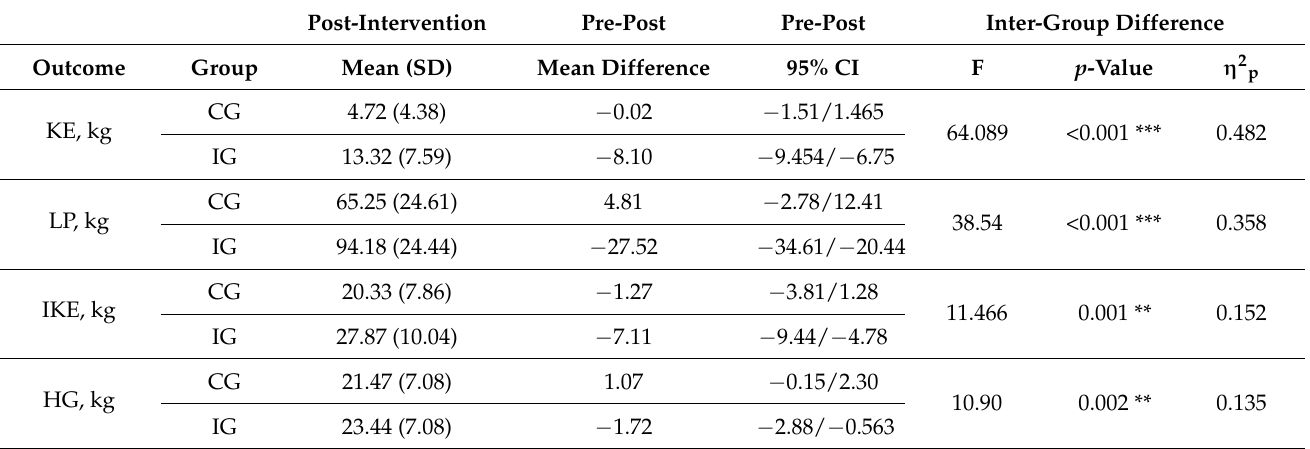
Table 4. Pre and post intervention values and time × group comparative analysis of muscle